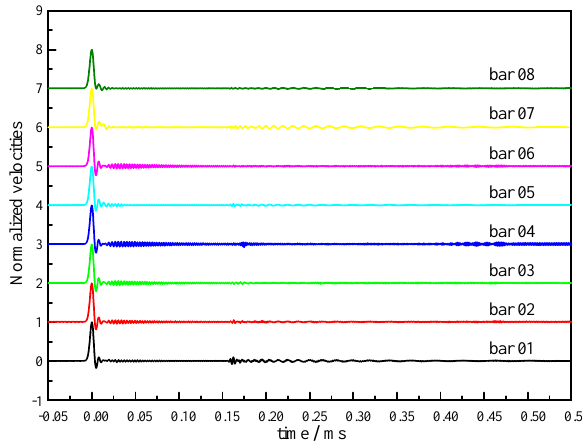
Figure 9. The testing signal of eight pressure bar sensors.